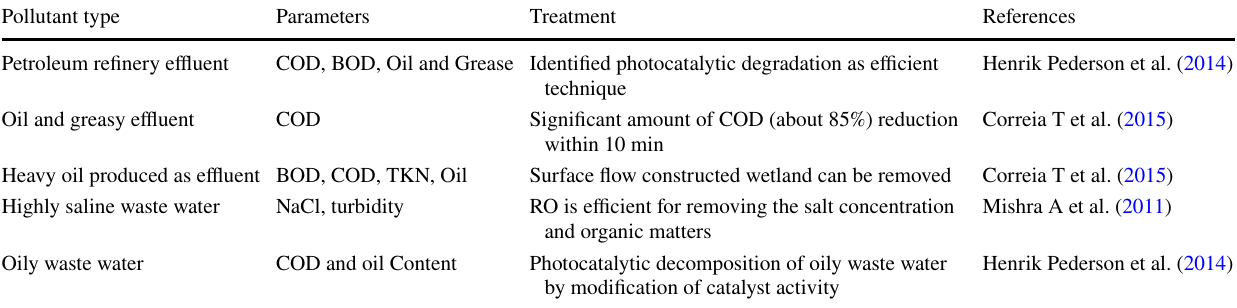
Table 3 Literature on petroleum waste water treatment, parameters and treatments Pollutant